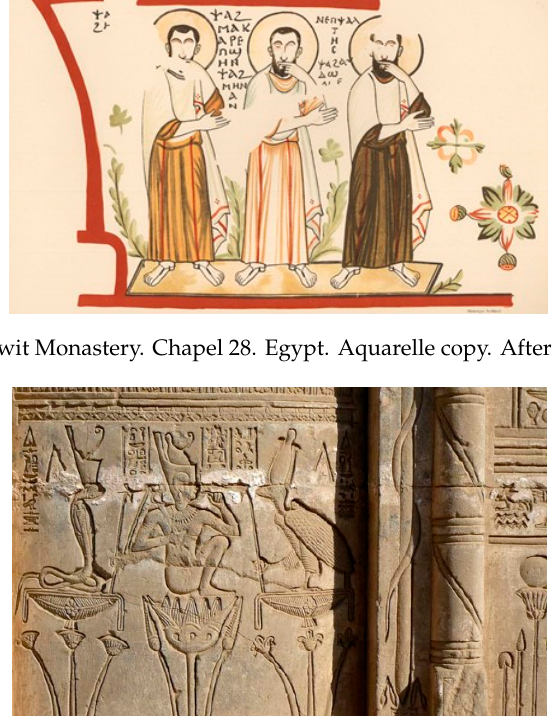
Figure 25. Ancien Egyptian singer, Iti in Tomb of Nikaw-ra. © Egyptian Museum Cairo.